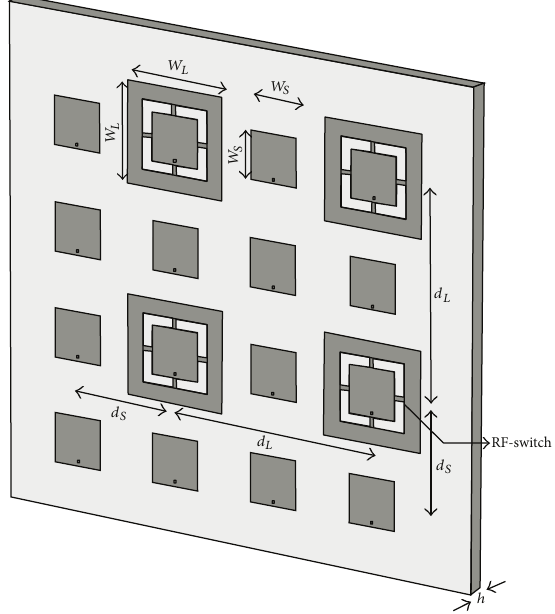
Figure 11: Reconfigurable ring-loaded patch antenna array